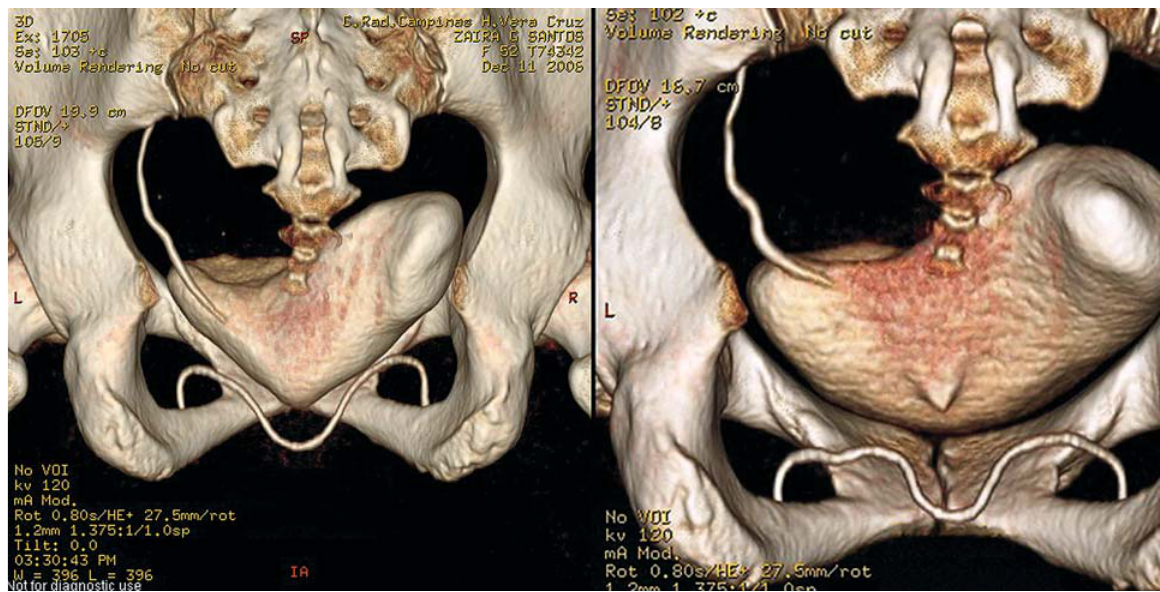
Figure 1 – Posterior views of a transobturator sling (Unitape ® - Promedon™) during strain and relaxation.